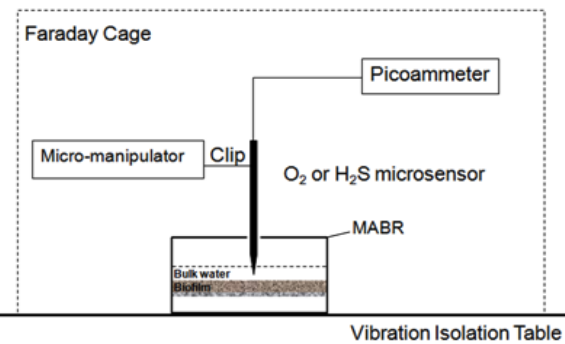
Figure 4. An illustration of the microelectrode measurement setup.